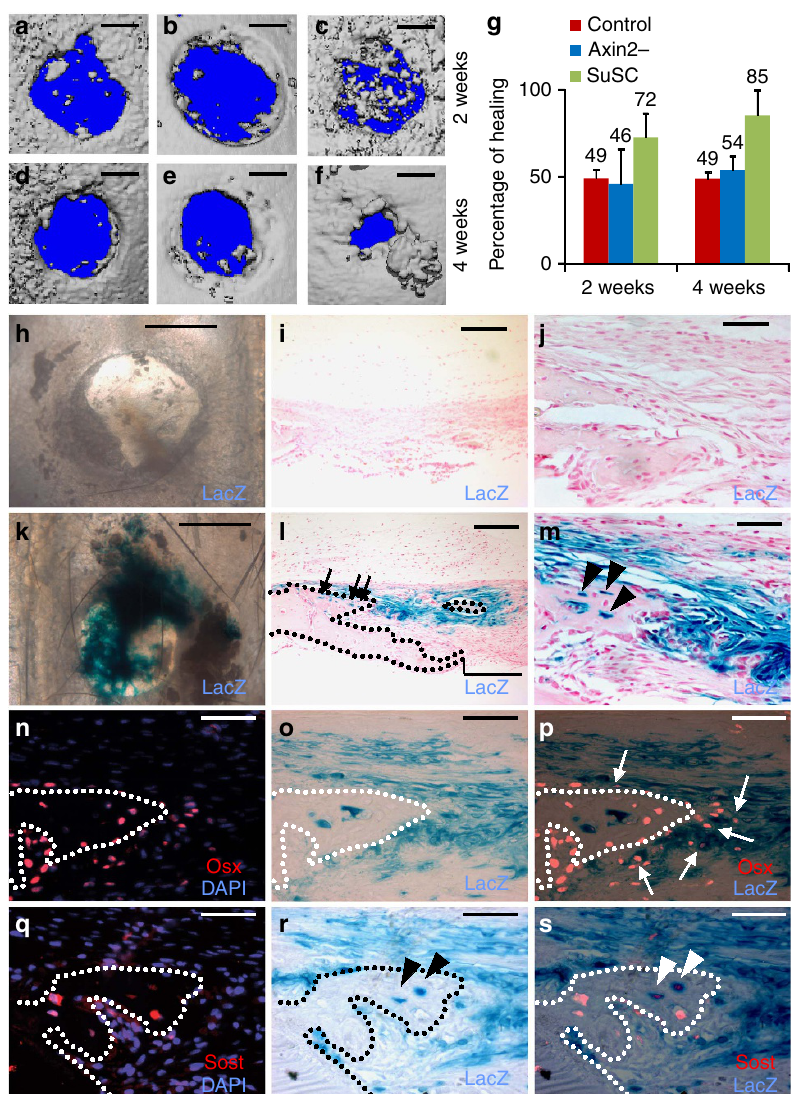
Figure 7 | SuSCs improve bone healing through direct engraftment. The reparative ability of SuSC is examined by implanting without ( a , d , h – j ), or with suture mesenchymal cells containing Axin2 – ( b , e ) or Axin2 þ ( c , f , k – s ) in the injury repair model. Two ( a – c , h – s ) and 4 ( d – f ) weeks after operation the healing process is assessed by micro CT ( a – f ), b -gal staining ( h – m , o – p , r – s ) and immunostaining of Osx ( n , p ) and Sost ( q , s ) in whole mounts ( a – f , h , k ) and sections ( i – j , l – s ). The graph shows the average per cent of healing at 2 and 4 weeks post operation ( g , n ¼ 3, mean ± s.e.m.; P value o 0.05, Student t -test). Arrows, arrowheads and bracket indicate osteoprogenitors, osteocytes and unhealed area, respectively. Images are representatives of three independent experiments. Scale bar, 500 m m ( a – f ). Scale bar, 1mm ( h , k ). Scale bar, 200 m m ( i , l ). Scale bar, 50 m m ( j , m – s